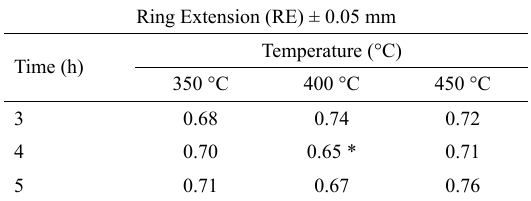
Table 2. Ring Extension (RE) results for samples nitrided under 6 Torr, at 350, 400 and 450 °C, for 3, 4 or 5h. Ring Extension (RE) ± 0.05